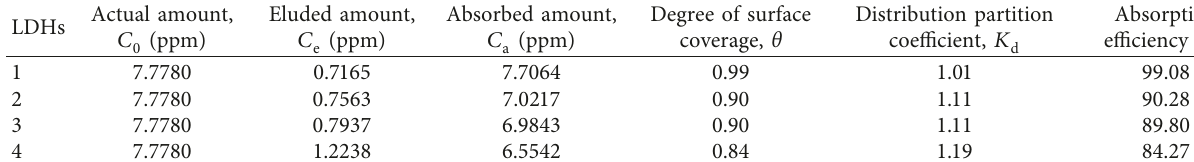
Table 2: Results of the adsorption study of Ca 2+